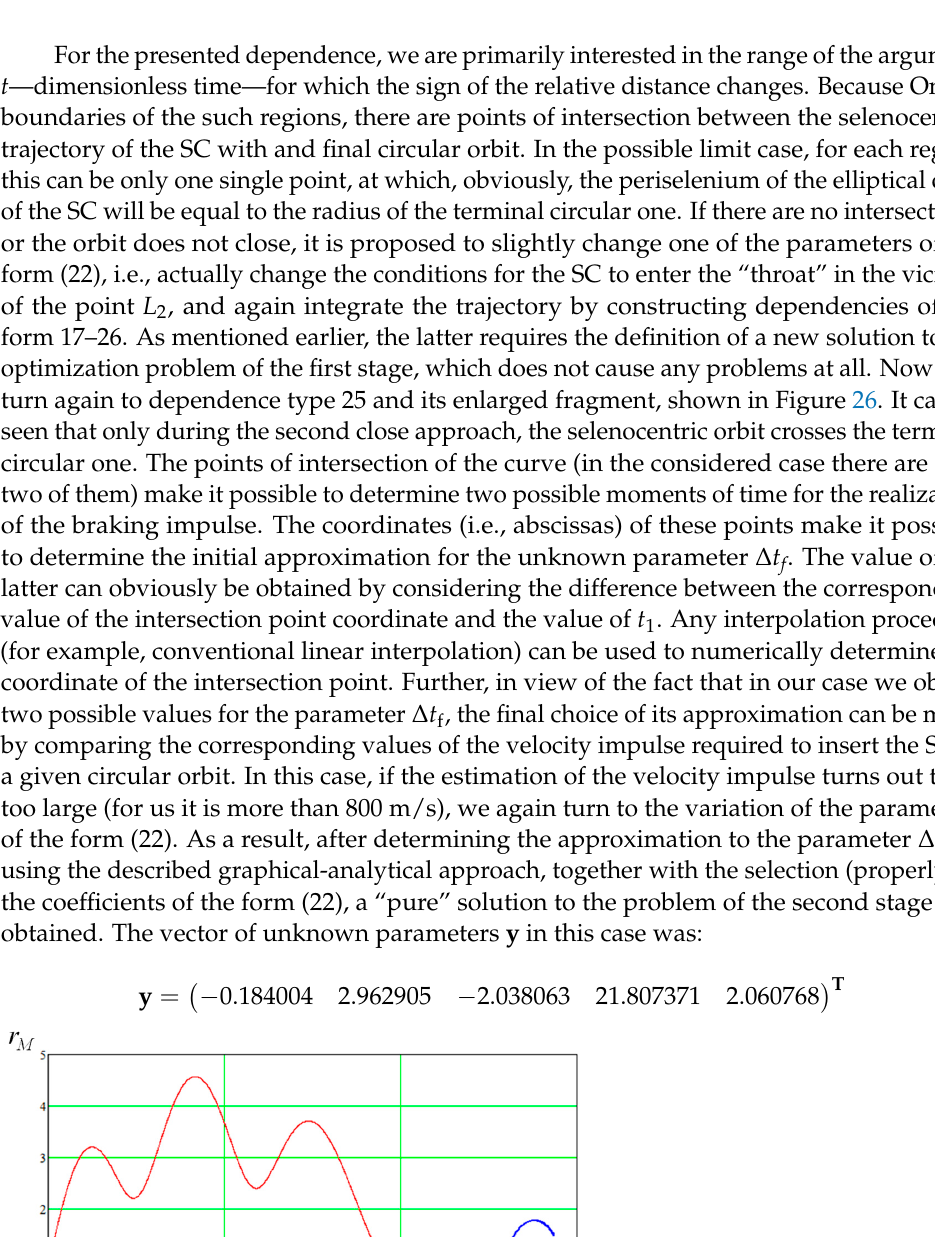
Figure 23. Selenocentric distance r M [undim.] along the full flight trajectory of the spacecraft. The area of “circumlunar” motion is marked in blue.